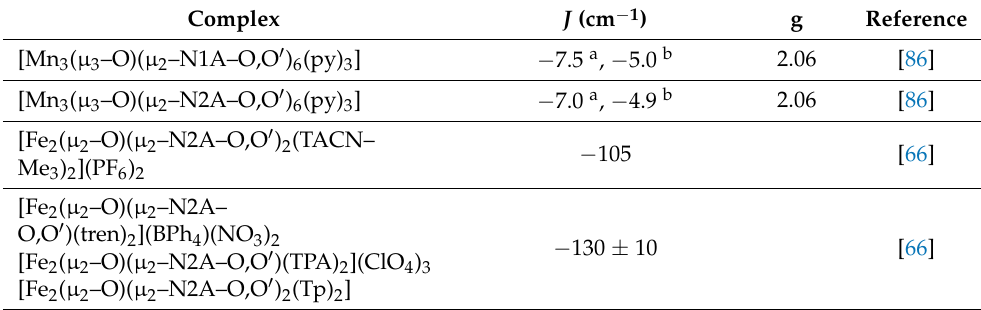
Table 7. Magnetic parameters derived from the fitting to temperature-dependent molar susceptibility of reported